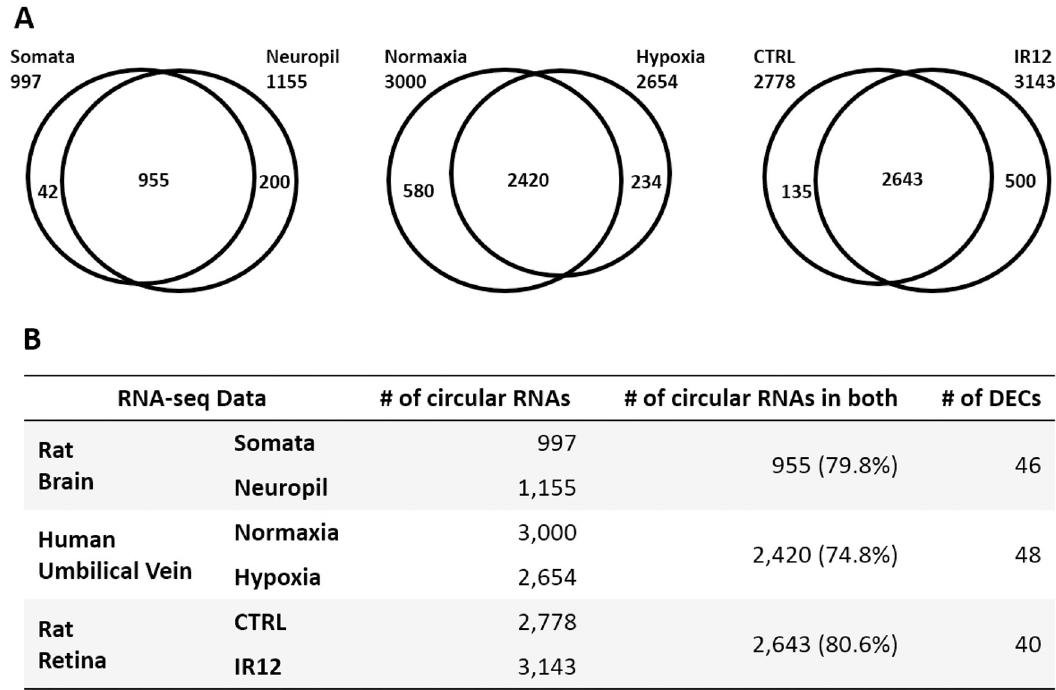
Fig 4. Composition of circRNAs. All three datasets showed that majority of circRNAs are expressed in both biological samples compared. DECs meet both | Δ PBI| > 5% and FDR <